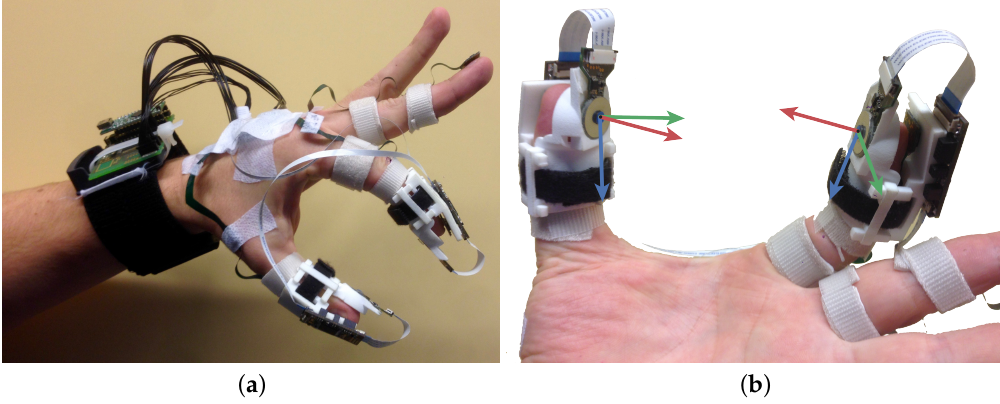
Figure 1. Force sensor instrumentation attached to the hand, index finger and thumb. The inertial kinematic instrumentation (described previously in Kortier et al. [22]) is attached to the dorsal side of the hand, index finger and thumb ( a ). Flexible PCBs allow the connection between the rigid sensor PCBs, which are placed on every digit. Custom-made cuffs (white 3D printed material) secure the force sensor attached to the tips and enforces a rigid connection to the local inertial sensor ( b ). Applied forces are transferred to the MEMS 6D force/torque sensor via a cylindrical (height = 3 mm, (cid:11) = 4 mm) glass stylus with rubber coating (blue, origin of the coordinate frames). The force sensor coordinate system is visualized with the x-axis (blue), y-axis (green) and z-axis